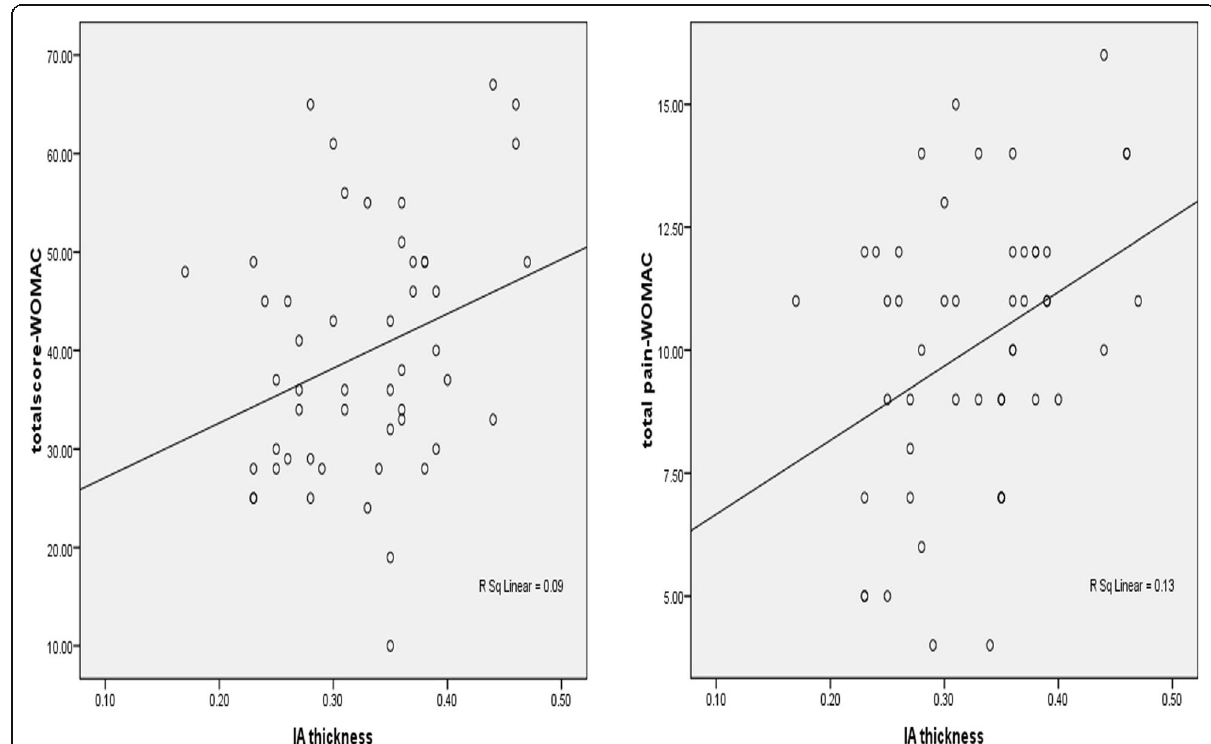
Fig. 3 Relationship between pain and the total WOMAC scores and IA thickness